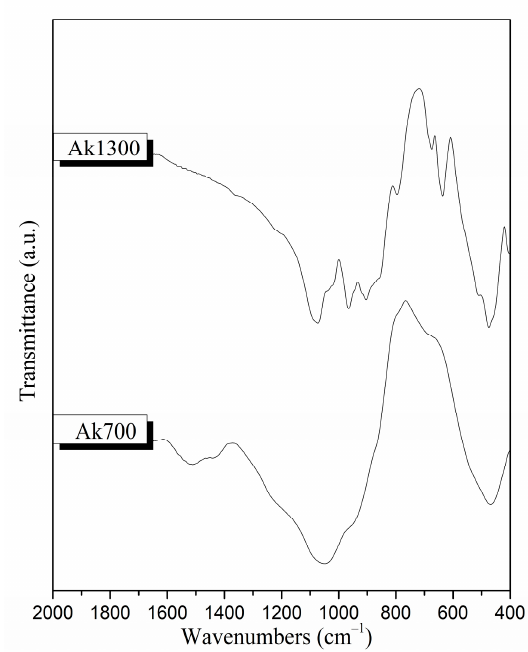
Figure 11. FTIR spectra of scaffolds after being heated to 700 and 1300 °C (Ak700 and Ak1300, respectively) before immersion in c-SBF.